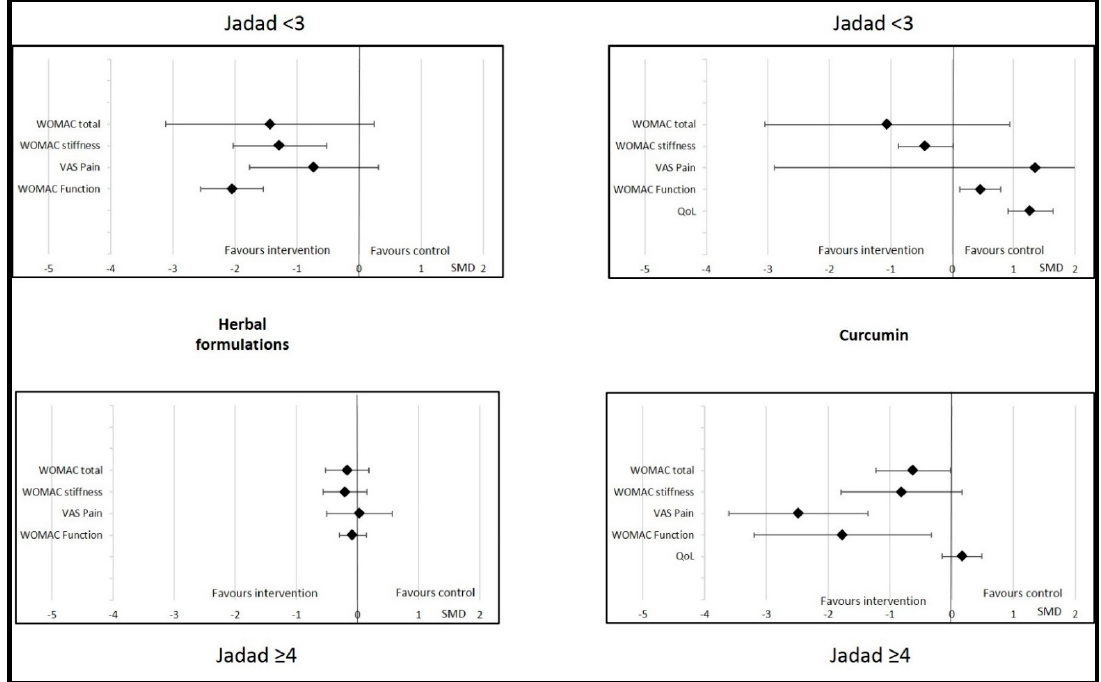
Figure 5. Effects of curcumin and herbal formulations on osteoarthritis parameters depending on Jadad score. Data are presented at standardized mean differences (SMDs) and confidence intervals. VAS = visual analogic scale; WOMAC = Western Ontario and McMaster Universities Osteoarthritis Index. QoL = quality of life.